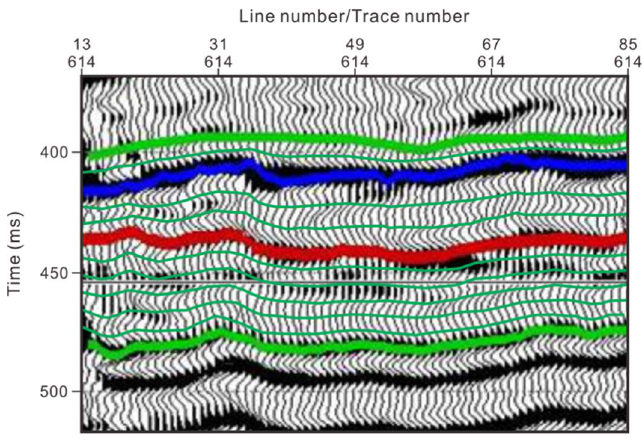
Figure 4. An example result of extracting stratigraphic